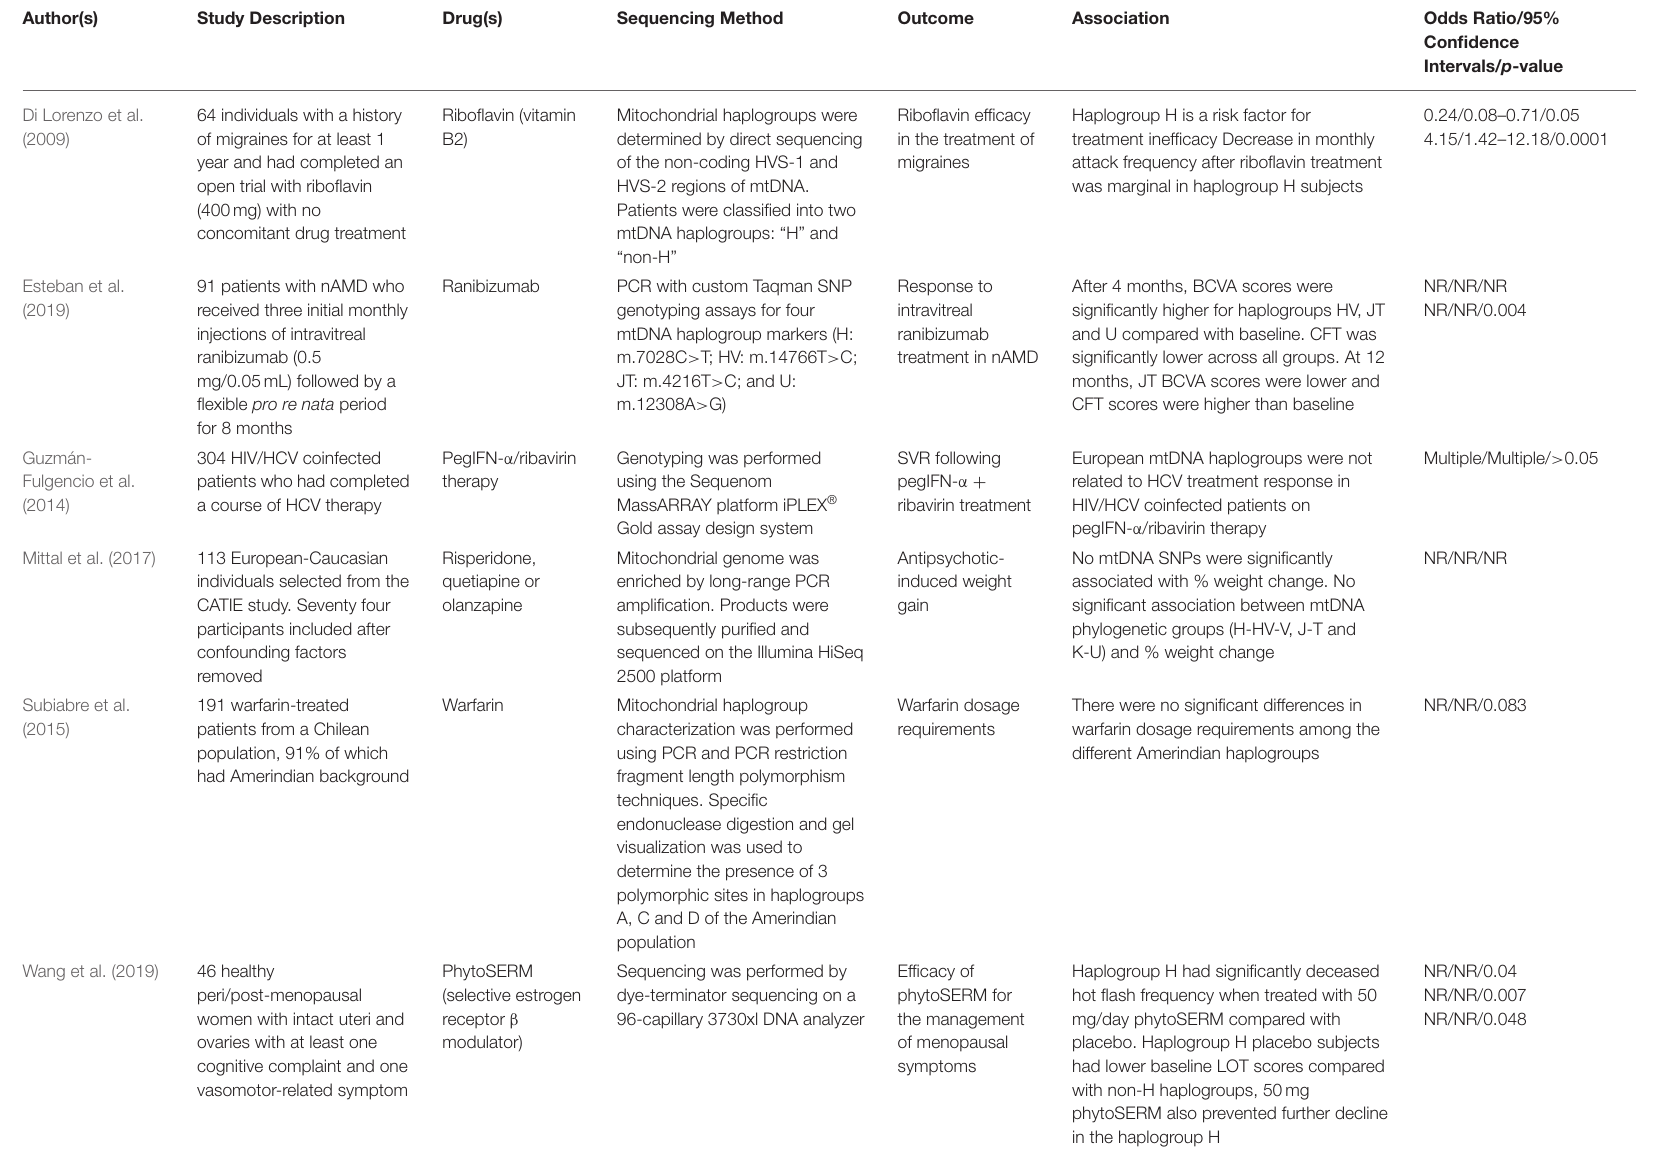
Abstraction table details the author(s), study design, drug(s) of interest, sequencing methods, outcomes, associations and statistics. BVCA, best corrected visual acuity; CATIE, clinical antipsychotic trails of intervention effectiveness; CFT, central foveal thickness; HCV, hepatitis C virus; HIV, human immunodeficiency virus; LOT, learning over trials; mtDNA, mitochondrial DNA; nAMD, neovascular age-related macular degeneration; NR, not reported; PCR, polymerase chain reaction; pegIFN- α , pegylated-interferon-alpha; SNP, single nucleotide polymorphism; SVR, sustained virological